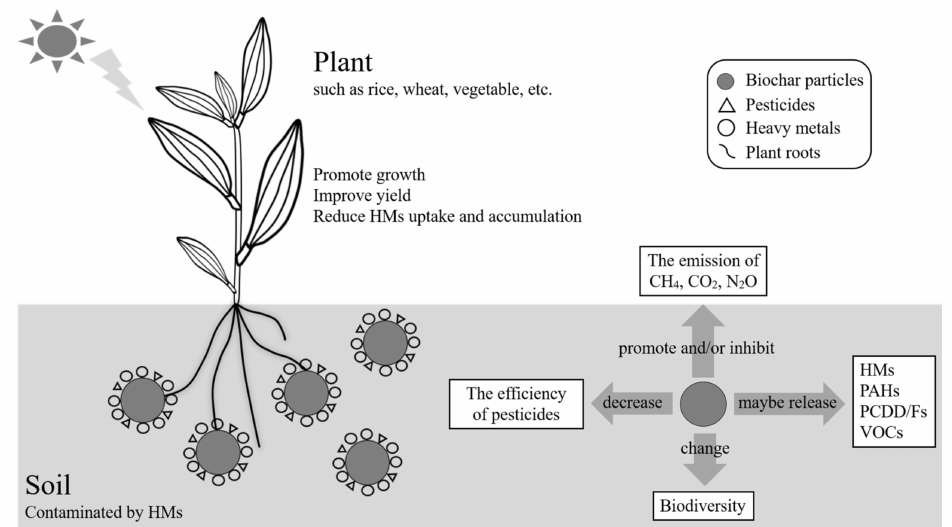
Figure 2. Advantages and disadvantages of biochar in the remediation of soil HM